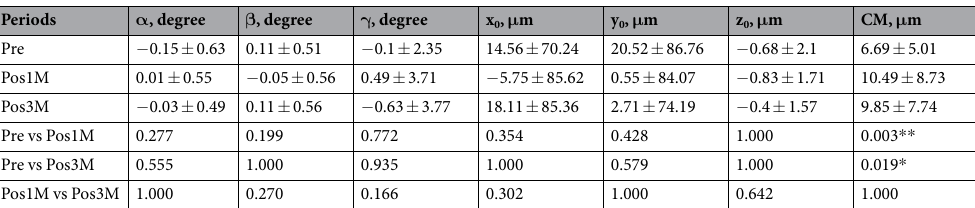
Table 4. Translational and rotational displacement results of the second measurement compared to the first one. Pre means the period pre operation, Pos1M means 1 month post LASIK, Pos3M means 3 months post LASIK; α , β , γ represent the angular rotations about the three main axes (x, y and z) of anterior and posterior corneal surface, respectively; x 0 , y 0 , z 0 represent the translational displacements of anterior and posterior corneal surface, respectively; Combined misalignment parameter (CM) developed to combine the effect of all these six misalignment components.